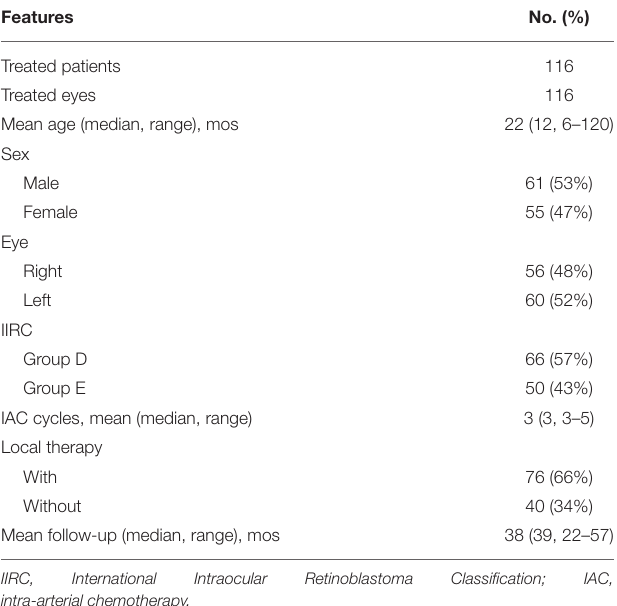
TABLE 2 | Patient